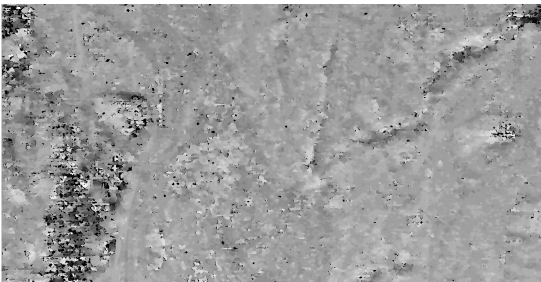
Figure 1: Disparity map for a TerraSAR-X stereopair The obtained local pixel disparity values are then converted into height differences with respect to the used approximated DSM through the computation of a conversion factor based on RPCs model. In particular a constant conversion factor is estimated starting from the metadata RPC orientation parameters on a 9 x 9 ground regular grid. Specifically at each point two heights are computed, a minimum height (equal to the lowest height in the image) and a maximum one (equal to the highest height in the image) in order to be sure to analyse the complete height range of the considered area. Through the RPCs the corresponding min- imum and maximum image points in master and slave images are computed from these minimum and maximum ground points, then the difference between master and slave (along i direction) between these minimum and maximum image points is